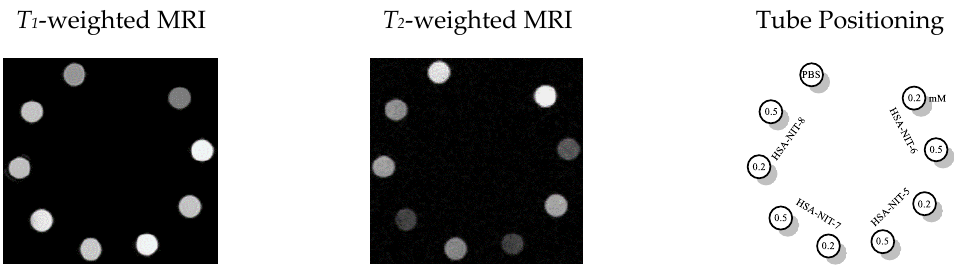
(Figure 4). There is no significant di ff erence in contrast e ffi ciency between the di ff erent types of nitroxides. The contrast di ff erences among samples correlate principally with their level of loading with nitroxide.